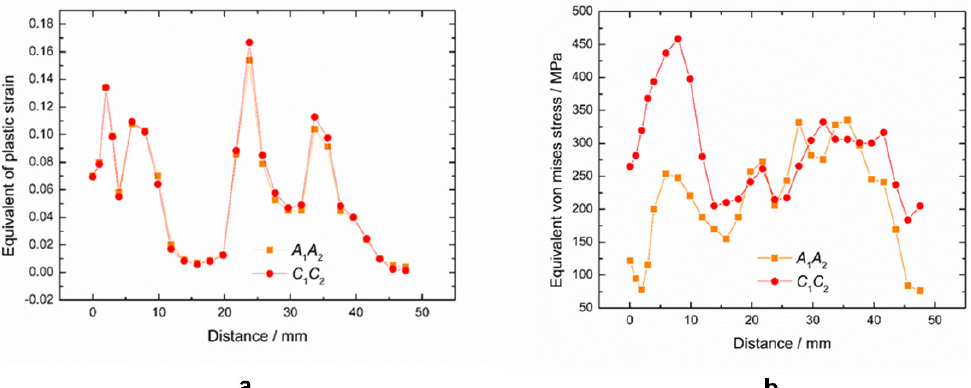
Figure 6. ( a ) Equivalent strain distribution and strain comparison; ( b ) Equivalent stress distribution and stress comparison between front part to behind part of the strip.